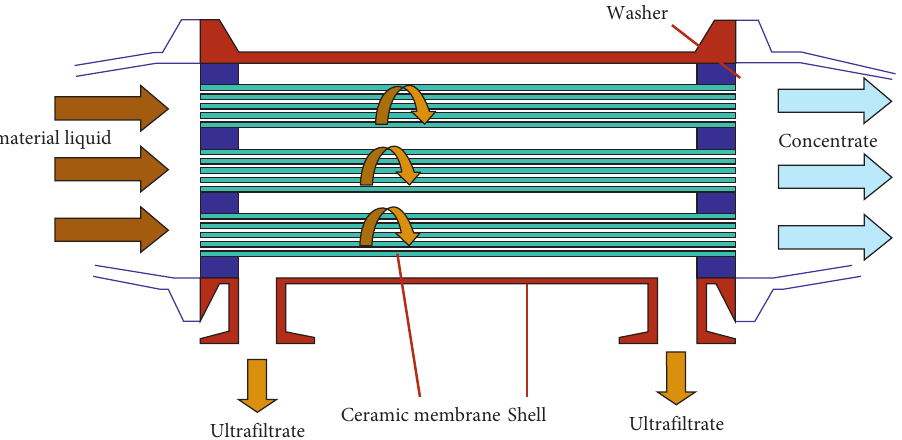
Figure 1: Tubular MBR